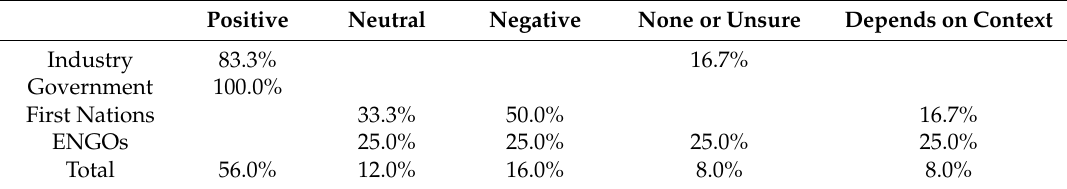
Table 4. Organization’s attitude (as reported by participant) towards the use of MAS in BC forests, represented as a proportion of each group and as a sample population total. Positive